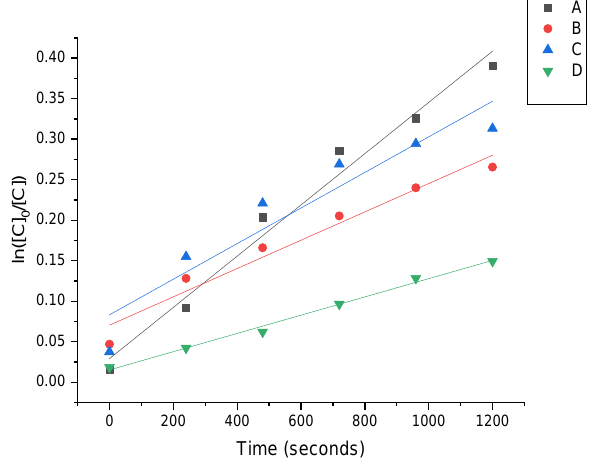
Figure 8. Graph illustrating the kinetics of the photocatalytic activity with varying concentration of dye and nanoparticles ( A ) MB—0.06 mg/mL, ZnO—0.2 mg/mL ( B ) MB—0.06 mg/mL, ZnO—0.1 mg/mL ( C ) MB—0.03 mg/mL, ZnO—0.2 mg/mL ( D ) MB—0.03 mg/mL, ZnO—0.1 Table 2. Values of concentration of MB, ZnO, first order rate constants and correlation coefficients for the photocatalytic degradation of MB.